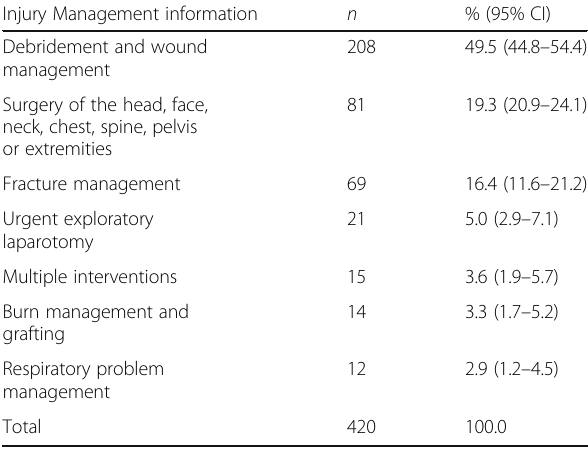
Table 4 Injury management ( n =